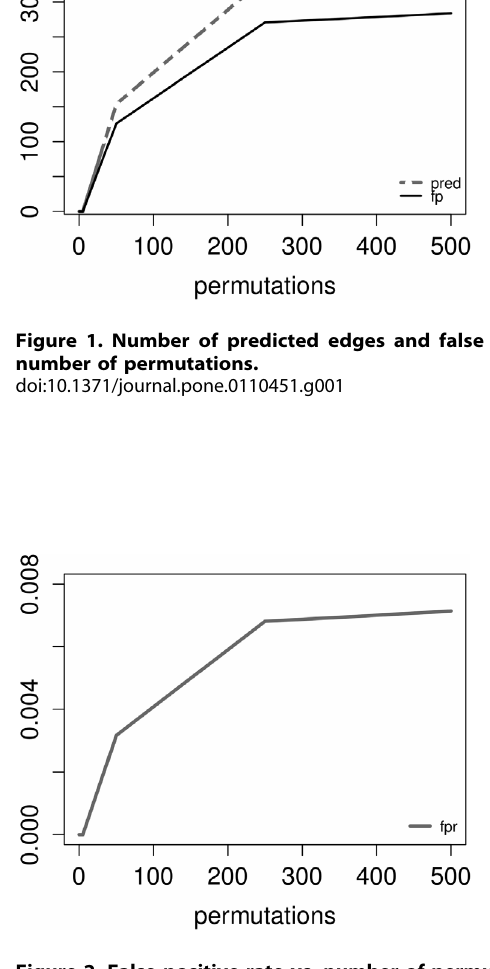
Table 2. Parameters of LABnet for both 50-node and 200-node networks.